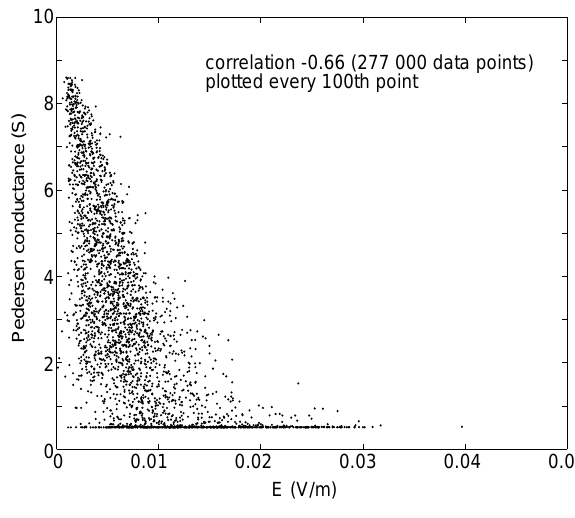
Fig. 11. Electric field versus Pedersen conductance over the time period of 23:30–06:00 UT in the GUMICS-4 simulation. Each point correspond to a time and location above 60 ◦ ; locations are obtained randomly over all MLT’s. Correlation coefficient is − 0 . 66. To re- duce data in the plot, only every 100th point is plotted (for those points, correlation is also − 0 .